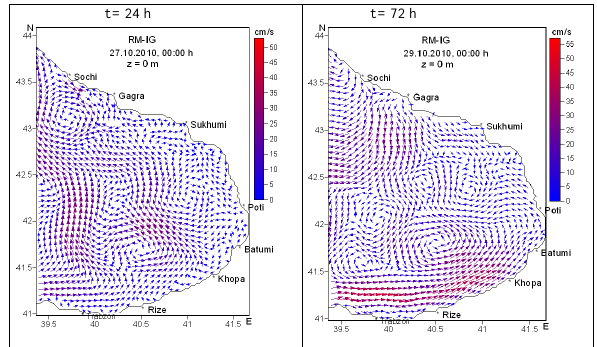
Fig. 13. Salinity field (psu) at 25.10.2010, 00:00 h on depths of 0 m (a) and 100 m (b).